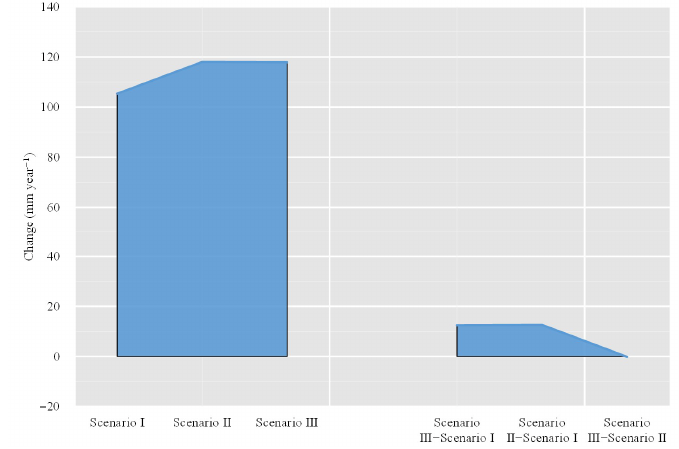
Figure 8. Simulation of the average annual values of GWS in the upper Ganjiang River basin due to climate change, land-use change, and the combined effects of all the above factors.